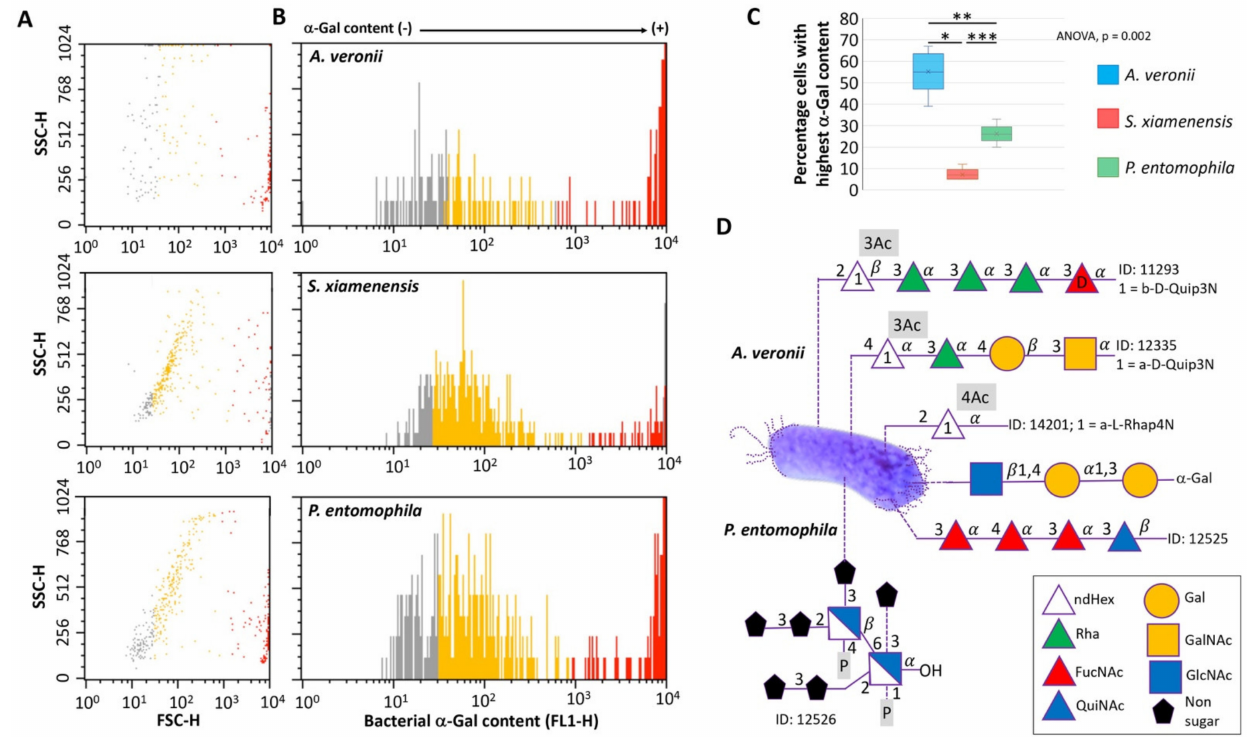
Figure 2. The carbohydrate structure and α -Gal content in potential probiotic bacteria. ( A ) Density plot representing bacteria that were gated by forward (FSC-H) and side (SSC-H) scatter. ( B ) Bacteria are represented in a histogram to evaluate the relative α -Gal levels (FL1-H). Cells were incubated with the α -Gal epitope monoclonal antibody M86. FITC-goat anti-mouse IgM-labeled antibodies were used as a secondary antibody. Samples were analyzed on a FAC-Scalibur flow cytometer equipped with CellQuest Pro software v.4. The viable cell population was gated according to forward-scatter (FSC-H) and side-scatter (SSC-H) parameters. ( C ) The percentage of viable cell population with highest α -Gal content (with mean fluorescence intensity >10 3 FSC-H; red marks) was compared between different bacteria by one-way ANOVA test ( p < 0.005) followed by post hoc Holm multiple comparisons (* p = 0.002, ** p = 0.02, *** p = 0.04, n = 5 biological replicates). ( D ) The bacterial carbohydrate structure for bacteria identified in the zebrafish microbiota with highest α -Gal content, namely A. veronii and P. entomophila , was characterized by using the Bacterial Carbohydrate Structure Database. The α -Gal was included as reported here in both bacteria. Compound IDs are shown. IUPAC condensed terms are disclosed in Materials and